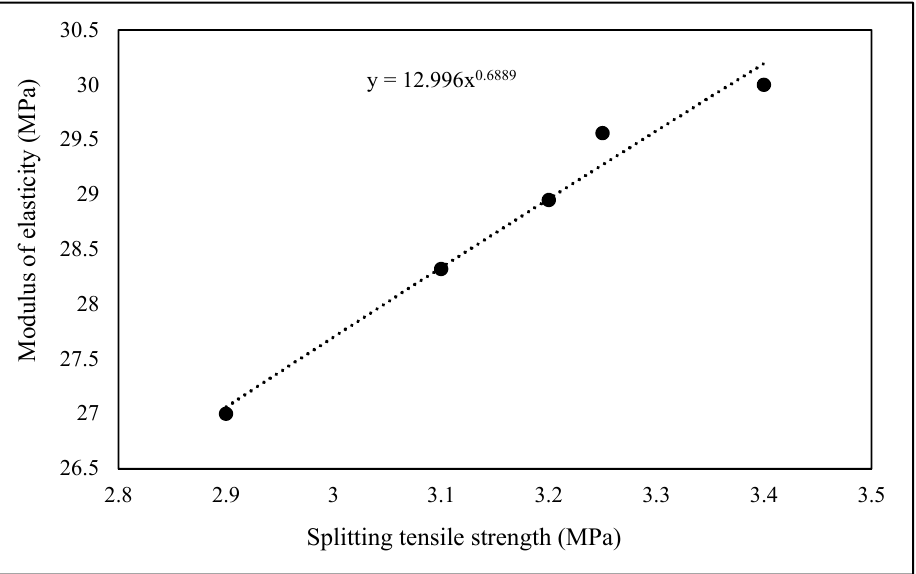
Figure 9. A meaningful correlation between the modulus of elasticity and splitting tensile strength, and an equation for estimation of 28th-day modulus of elasticity from splitting tensile strength.